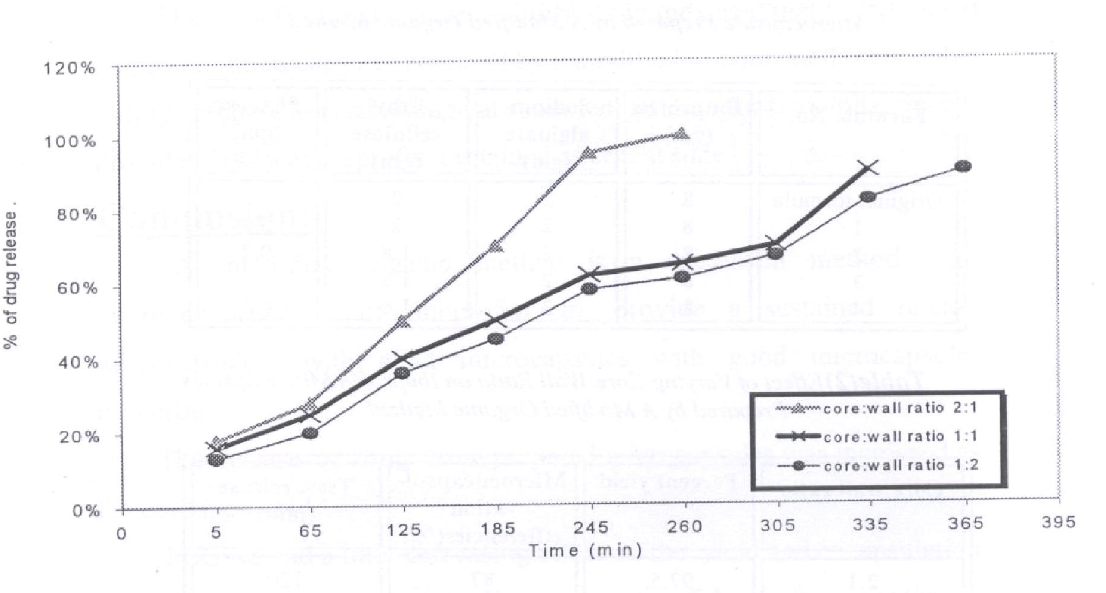
Figure(1): Effect of varying core:wall ratio on the release property of ibuprofen microcapsules prepared by a modified organic method using pH 6.8 phosphate buffer at